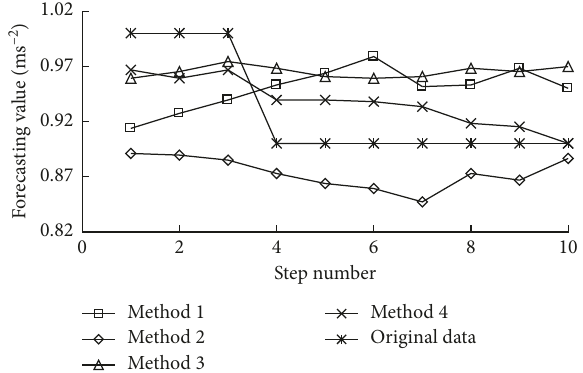
Figure 3: Chaotic prediction results for subseries X